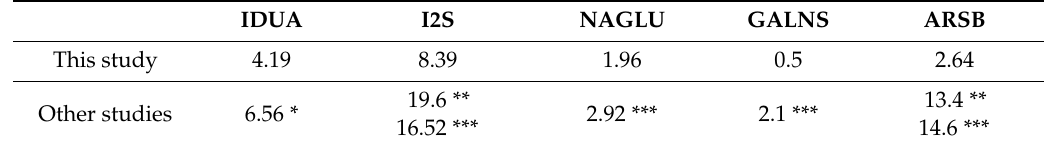
Table 2. Mean enzyme activity of healthy subjects ( µ M /